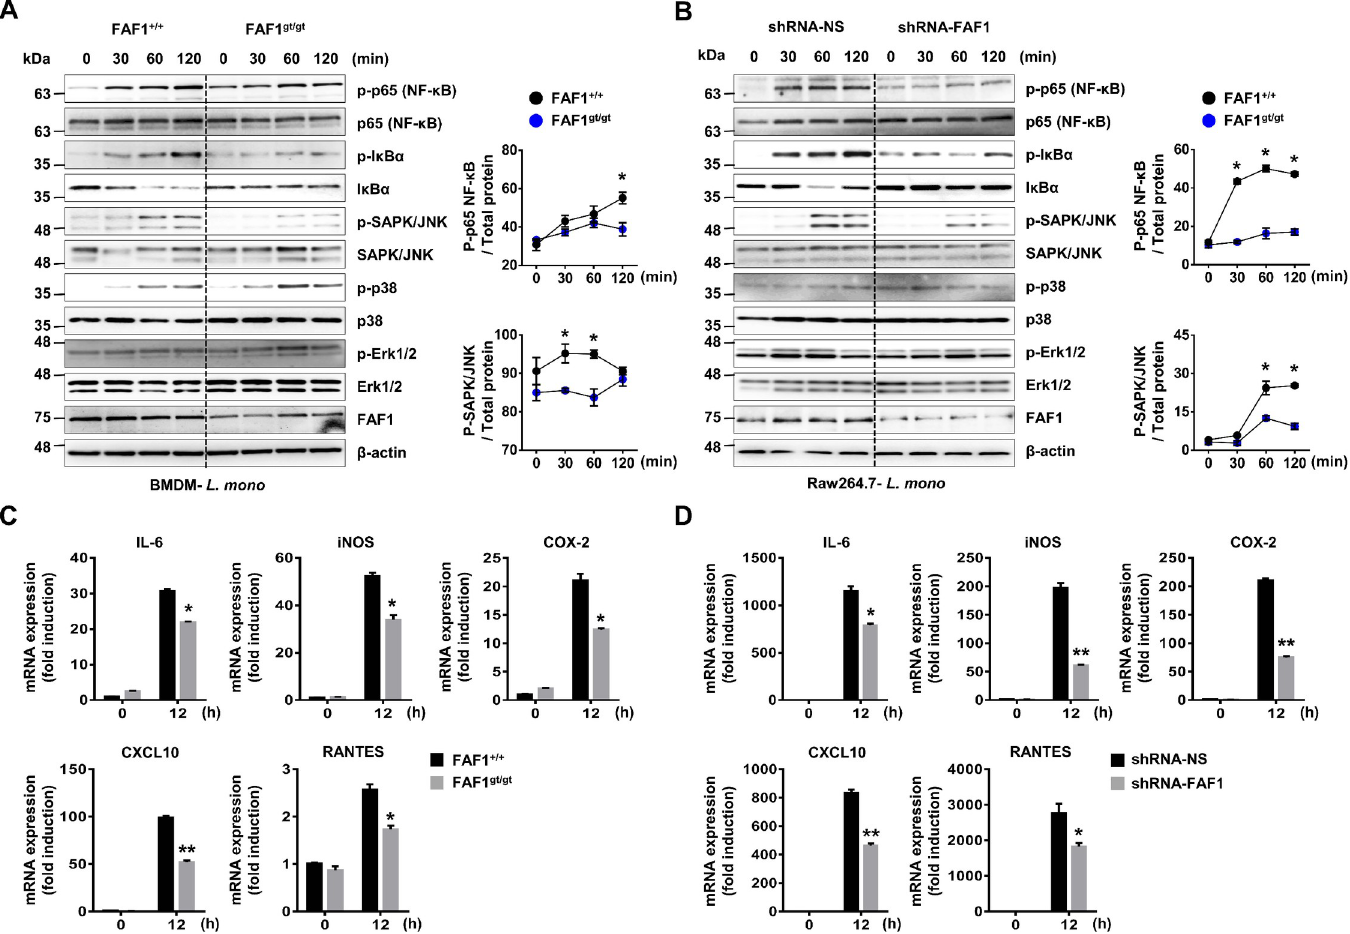
Fig 2. Knockdown of FAF1 reduces proinflammatory responses upon infection with L . monocytogenes in macrophages. (A) FAF1 +/+ and FAF1 gt/gt BMDMs were infected with L . monocytogenes (MOI = 1) for the indicated times, and subjected to immunoblotting with phosphorylated and total forms of p65, I κ B α ,JNK, p38, p42/p44 MAPK, FAF1 and β -actin (left). Band intensity of each blot was shown in graphs (Right). (B) Control Raw264.7 cells (shRNA-NS) and FAF1 knockdown Raw264.7 cells (shRNA-FAF1) were infected with L . monocytogenes (MOI = 1) for the indicated times, and then subjected to immunoblotting with the phosphorylated and total forms of p65, I κ B α , JNK, p38, p42/p44 MAPK, FAF1 or β -actin (left). Band intensity of each blot was shown in graphs (Right). (C) FAF1 +/+ and FAF1 gt/gt BMDMs were infected with L . monocytogenes (MOI = 3) for 2hrs. At 12 hpi, cells were harvested and analyzed by quantitative real-time PCR analysis for IL-6, iNOS, COX-2, CXCL10, and RANTES genes. (D) Control Raw264.7 cells (shRNA-NS) and FAF1 knockdown Raw264.7 cells (shRNA-FAF1) were infected with L . monocytogenes (MOI = 1) for 2hrs. At 12 hpi, cells were harvested and analyzed by quantitative real-time PCR analysis for IL-6, iNOS, COX-2, CXCL10, and RANTES genes. Data are representative of two (A, B) or three (C, D) independent experiments. Error bars, mean ± SD. � P < 0.05, �� P < 0.01 (Student‘s t -test), compared to control (FAF1 +/+ or shRNA-NS).